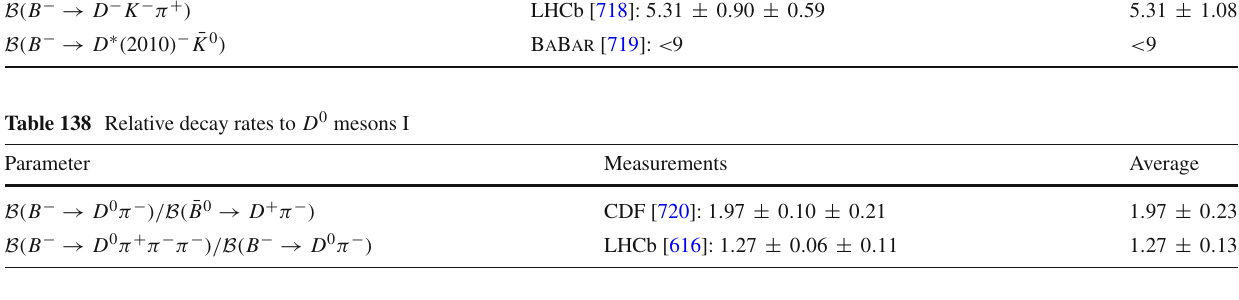
Table 139 Relative decay rates to D 0 mesons II [ 10 − 2 ] Parameter